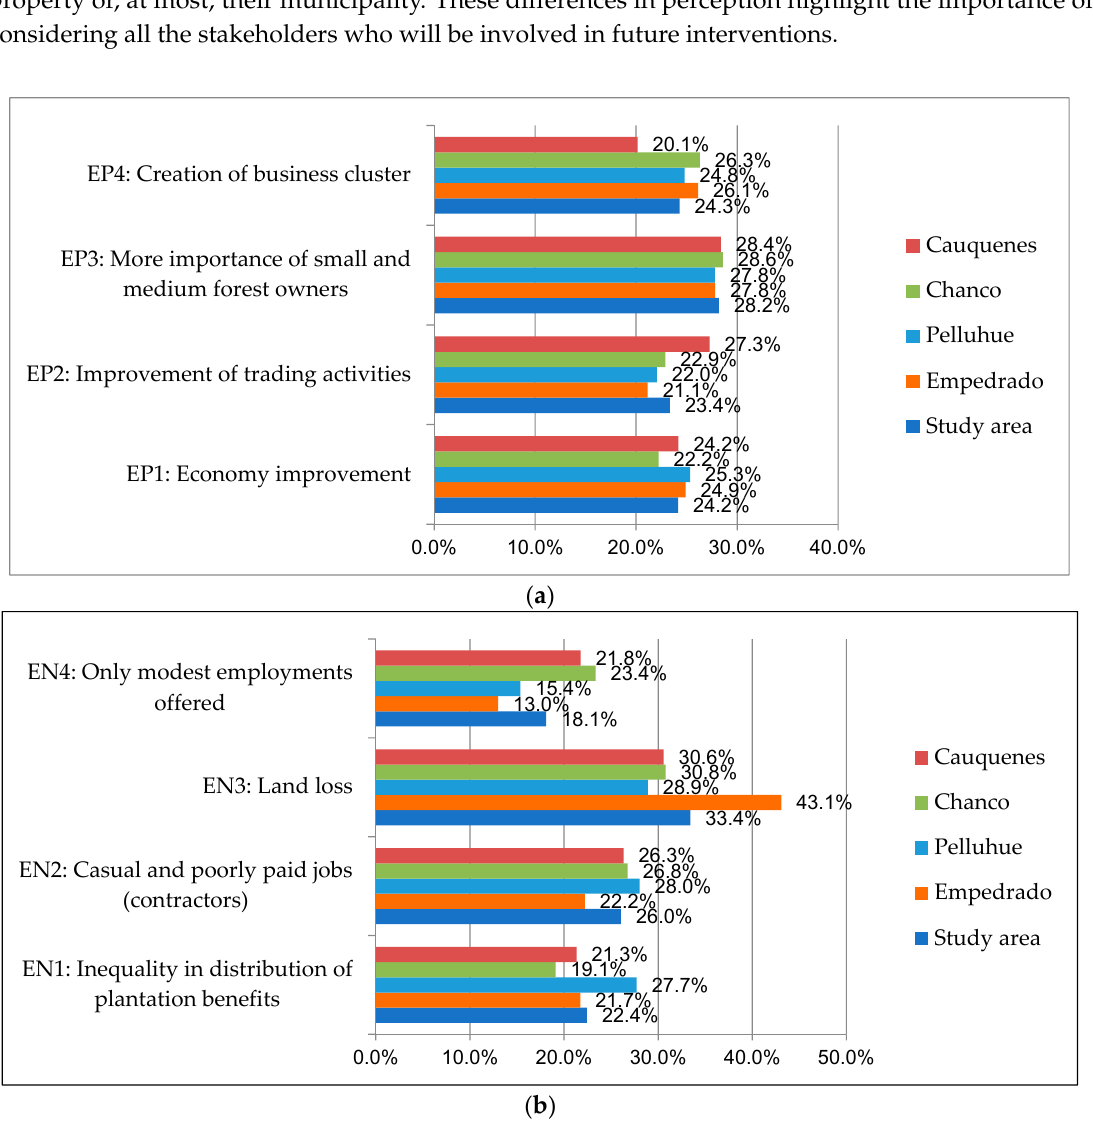
Figure 8. Economic externalities: comparison among municipalities ( a ) positive externalities; ( b ) negative externalities.